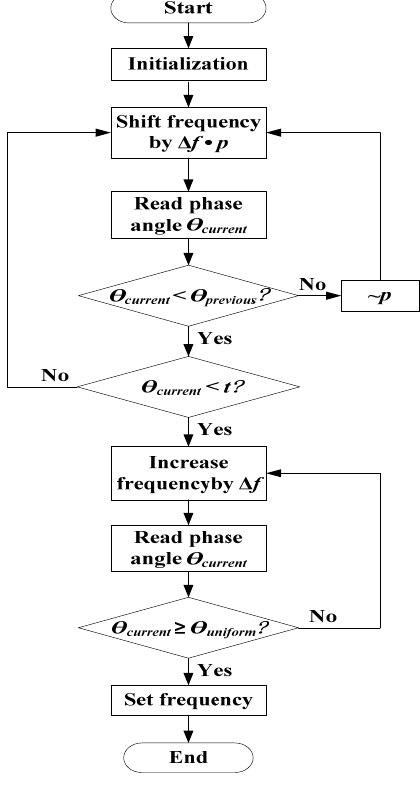
Figure 5. Flowchart of the uniform voltage gain control